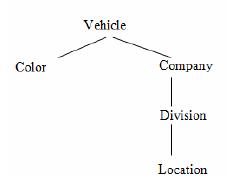
Figure 3. Query tree